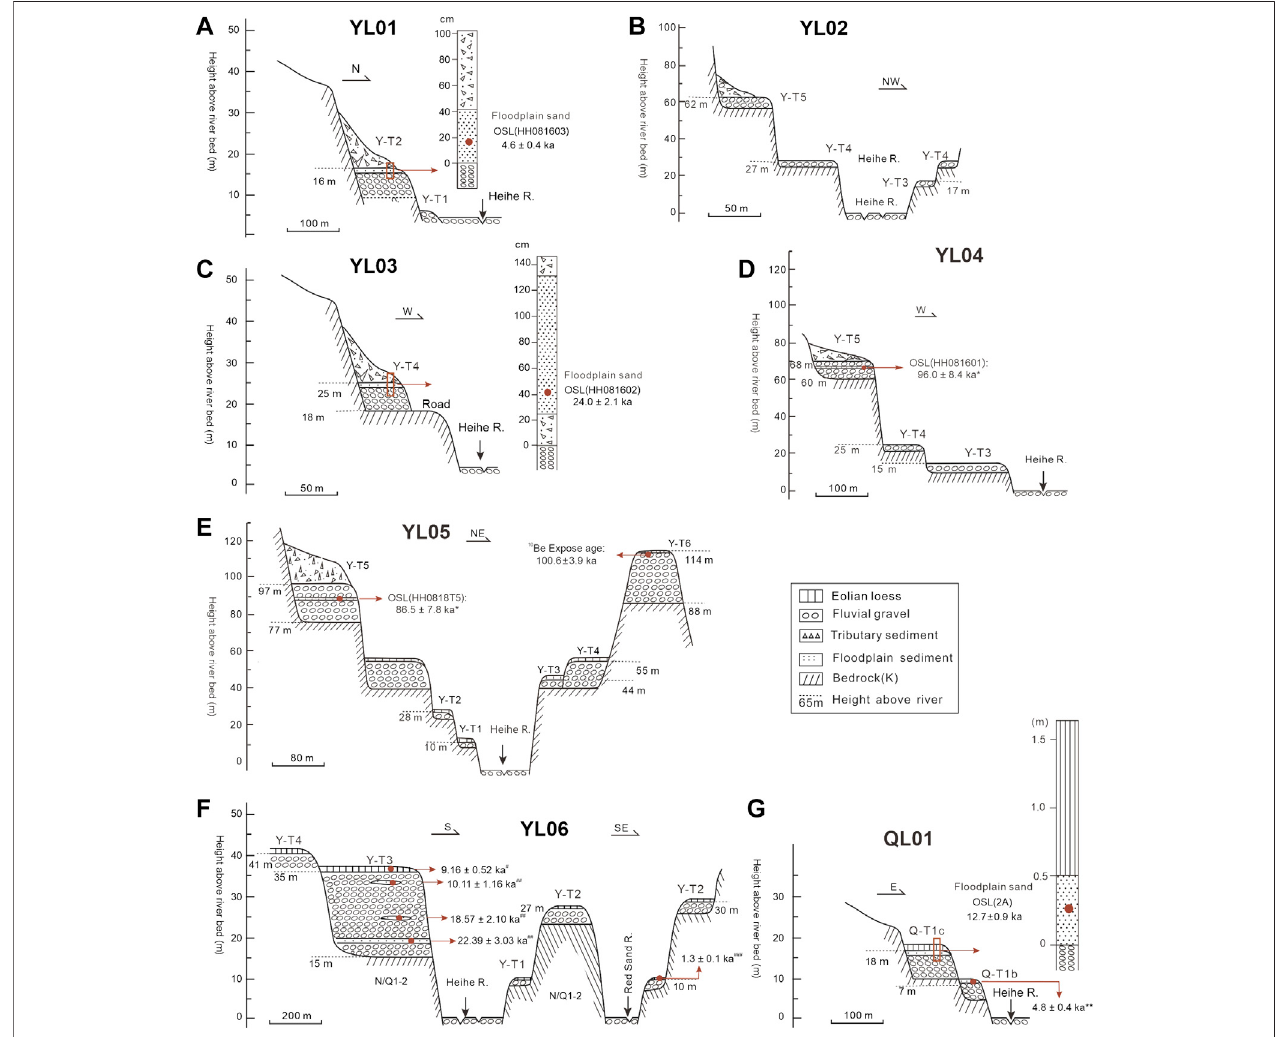
FIGURE 4 | Geomorphic transects along the Heihe River, showing the terrace staircases, the composition of each terrace level, and the locations of the samples used for terrace dating. YL01-YL05 are located in the Zoulang Nan Shan site, YL06 is located in the mountain front site and QL01 is located in the Qilian basin site. The locationsofthe transects areshown in Figure 3 . Note: * indicates theexcludedages ofterrace deposits; ** indicates ages from Hu et al.(2021); # indicates ages from Li et al. (1999); ## indicates ages from Ren et al. (2019) and ### indicates ages from Hetzel et al. (2004).